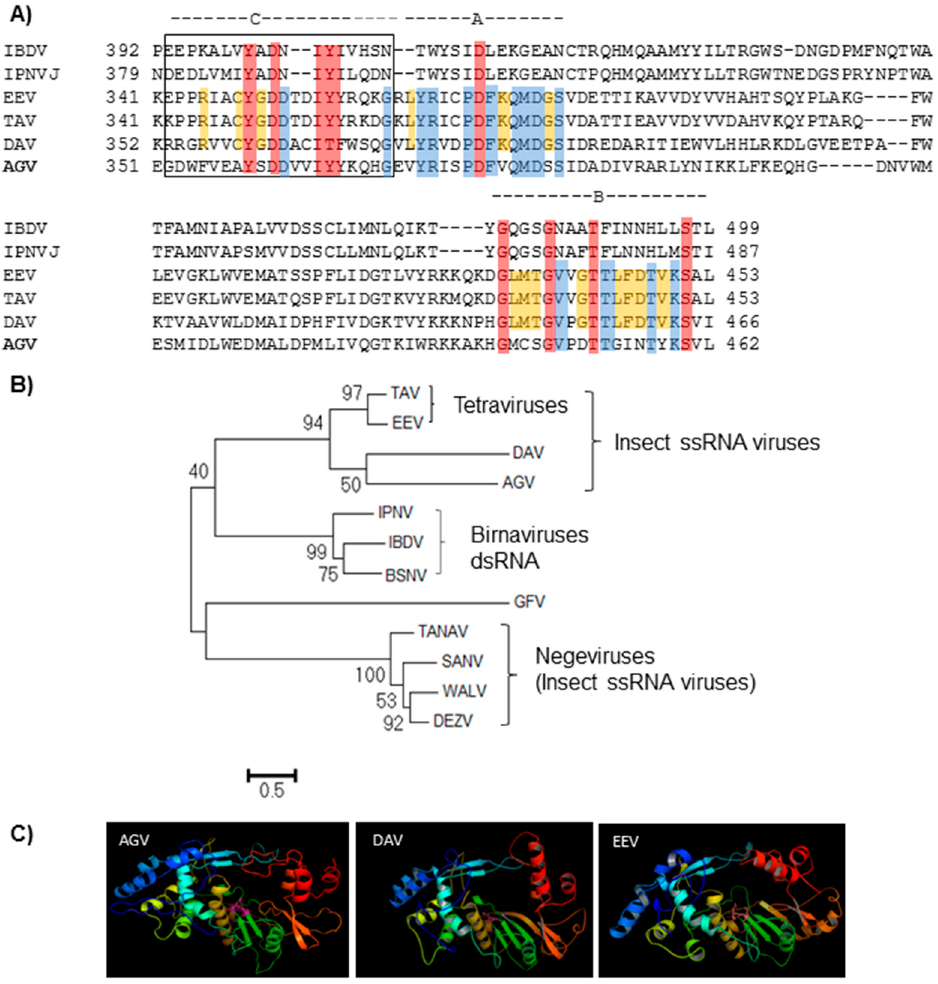
Figure 2. ApGlV2 has a non ‐ canonical (C ‐ A ‐ B) RdRp, similar to those of some other insect viruses. ( A ) The conservation of the amino acid residues between ApGlV2, the tetraviruses; Thosea asigna virus (TAV) and Euprosterna elaeasa virus (EEV); Drosophila A virus (DAV) and birnaviruses; Infectious pancreatic necrosis virus (IPNV) and Infectious bursal disease virus (IBDV) are highlighted. Yellow highlights show conservation between EEV, TAV, and DAV but not ApGlV2 while blue highlights show conservation of EEV, TAV, and DAV with ApGlV2. Red highlights show conservation of residues between all viruses. All highlighted amino acids are key RdRp motifs. ( B ) Phylogenetic tree of ApGlV2 RdRp with closely related viruses and other viruses with permuted RdRp based on BLAST results of amino acid identity. Phylogenetic trees were constructed using MEGA 6.06 with the maximum likelihood method. Thosea asigna virus (TAV, accession AAQ14329.1) and EEV (AF461742_1) are closely related to but phylogenetically distinct from DAV (YP003038595.1) and ApGlV2 (AGV). The RdRps of these insect viruses are clustered with Birnaviruses, e.g., Infectious pancreatic necrosis virus (IPNV; AAV48847.1), Infectious bursal disease virus (IBDV; ACS44343.1), and Blotched snakehead virus (BSNV; YP052864). In contrast, the RdRps of negeviruses with permuted RdRps, Dezidougou virus (DEZV, AFI24669.1), Santana virus (SANV, AFI24675.1), Wallerfield virus (WALV, AIS40860.1), and Tanay virus (TANNV, YP_009028558.1) are close to a plant virus, Grapevine fleck virus (GFV, CAC84400.1), forming a distinct branch and indicating that the RdRps of negeviruses are distinct from that of ApGlV2; ( C ) The predicted RdRp structures for ApGlV2 (AGV), DAV, and EEV are similar. Homology modeling of tertiary protein structures of RdRp from ApGlV2, Drosophila A virus (DAV), and Euprosterna elaeasa virus (EEV). Images were generated using the LOMETS server.